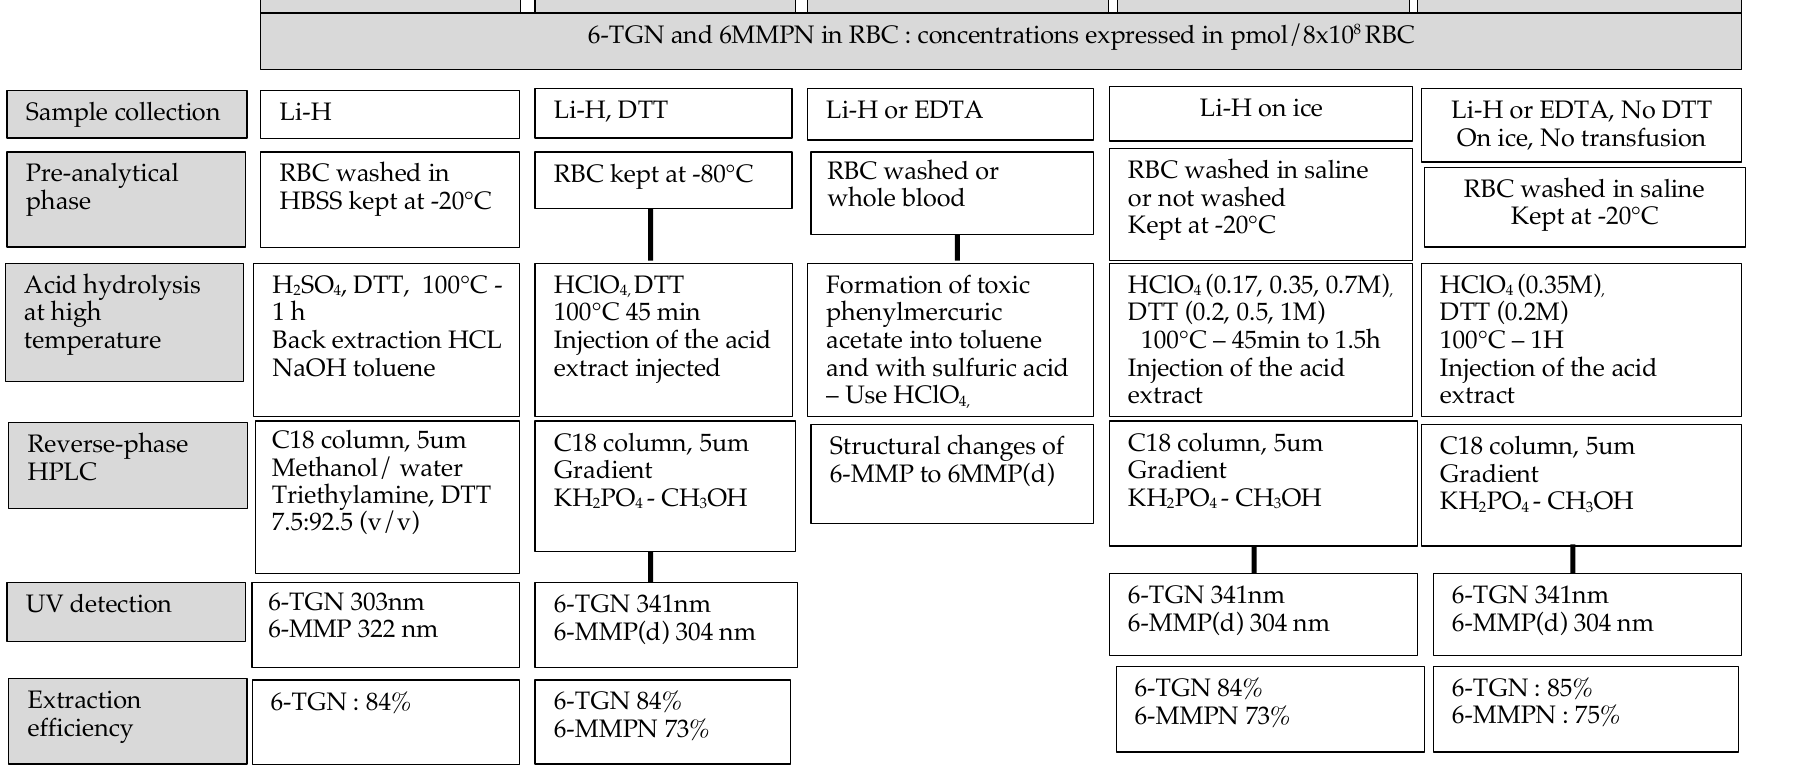
Figure 4. Summary of the first pre-analytical and analytical procedures by Lennard and Singleton and by Dervieux and Boulieu [27–29], the major modifications (presented in detail in Table S6) and a proposed standardized procedure based on additional